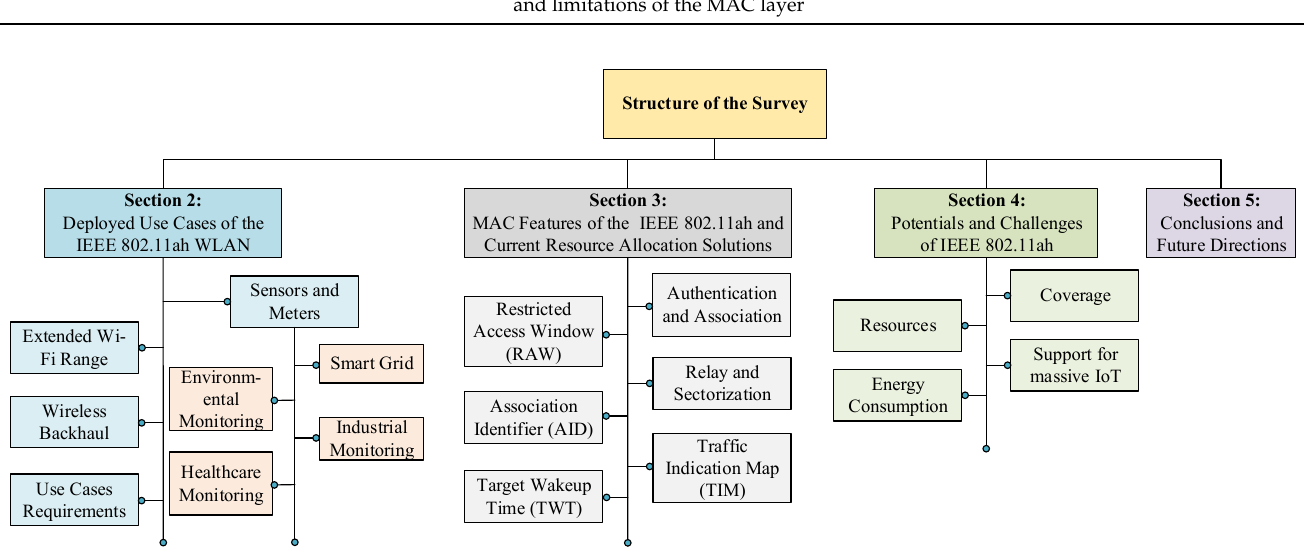
Figure 1. Outline of the survey